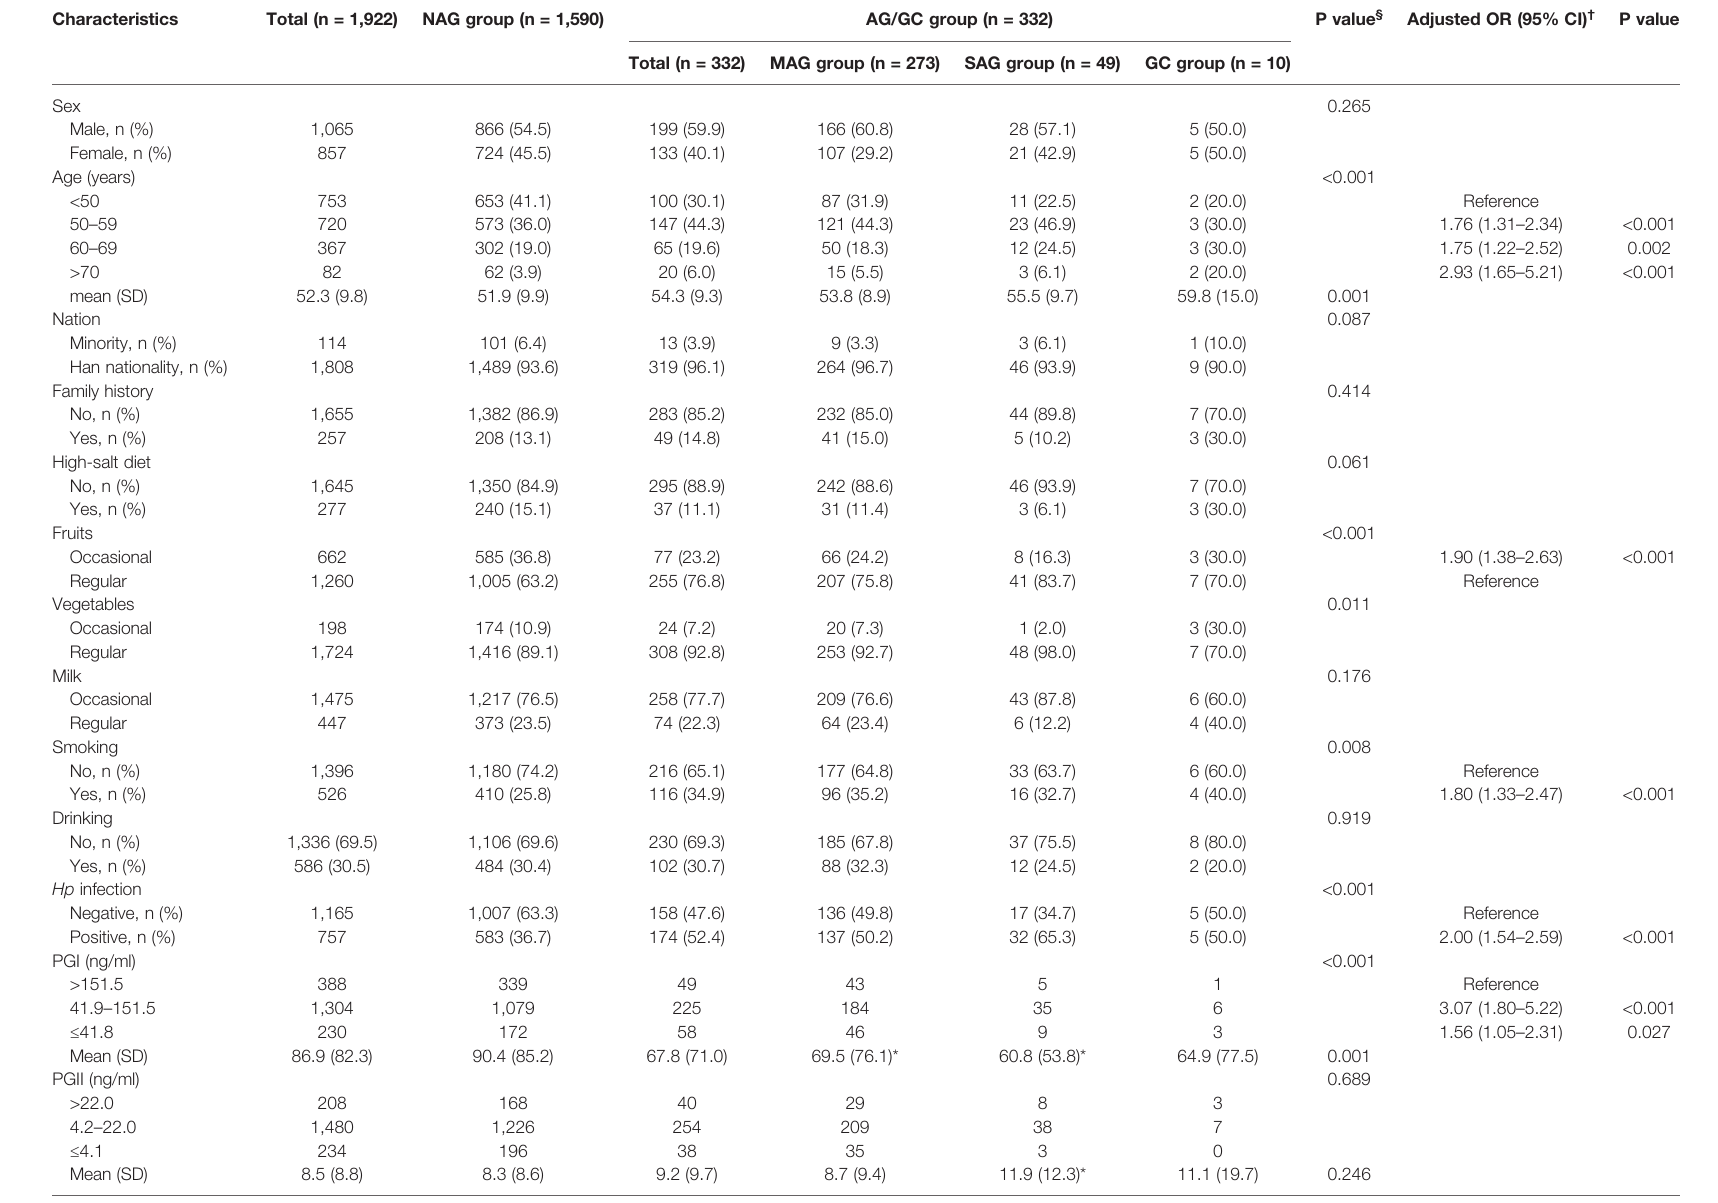
TABLE 1 | The baseline characteristics of 1,922 subjects involved in the study, with univariate and multivariable analyses.